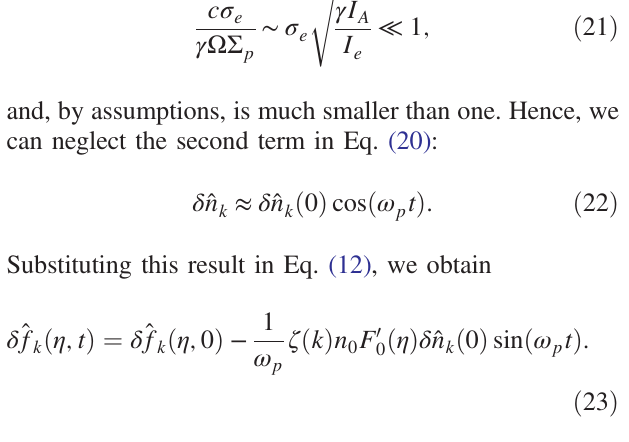
ffiffiffiffiffiffiffiffiffiffiffiffiffiffiffiffiffiffiffiffiffi p 2 ϰ H ð ϰ p p Þ